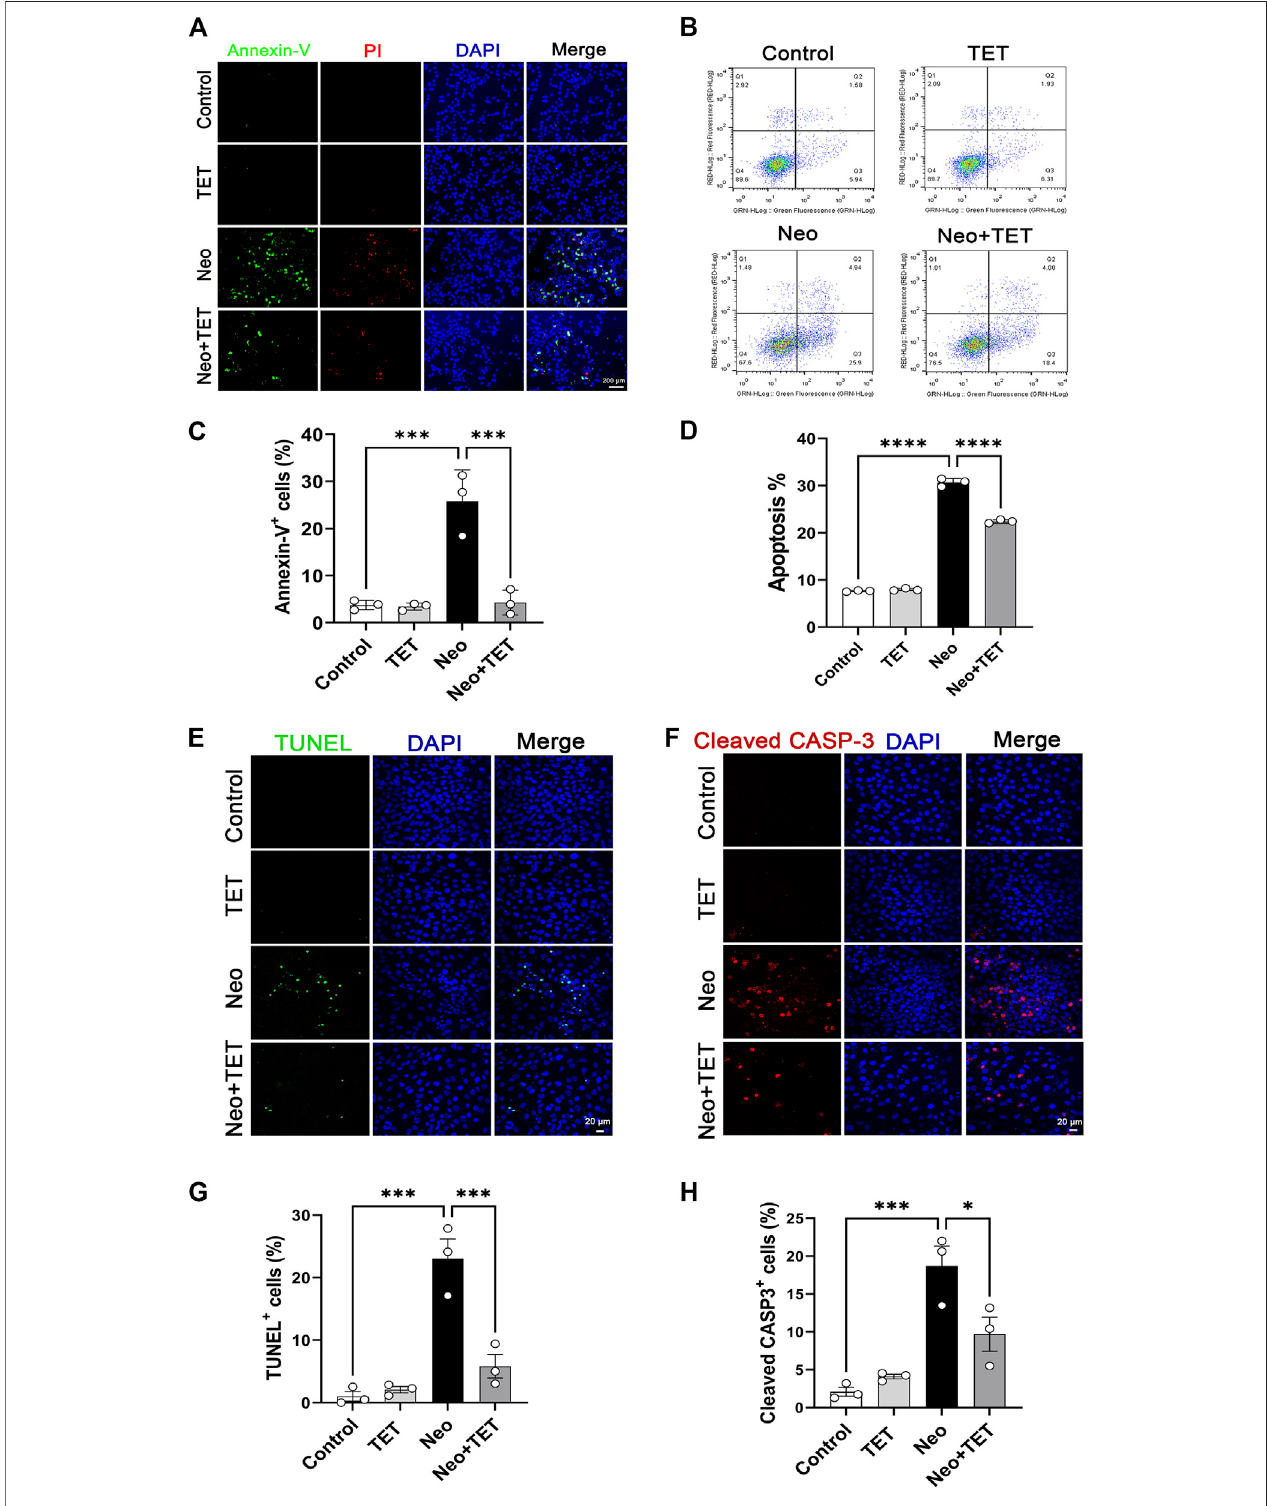
FIGURE3| EffectsofTETonneomycin-stimulatedapoptosisinHEI-OC1cells (A) Annexin-V/PIstaininginHEI-OC1cellsafterTETtreatmentfollowedbyneomycin stimulation.Scalebars:200 μ m (B) ApoptosisanalysisofHEI-OC1cellsby fl owcytometry (C) Quanti fi cationofthenumbersofAnnexin-V-positiveHEI-OC1cellsin (A) (n = 3) (D) Quanti fi cation of the proportions of apoptotic cells (n = 3) (E,F) TUNEL and cleaved caspase-3 staining of HEI-OC1 cells after TET administration followed by neomycin exposure. Scale bars: 20 μ m (G,H) Quanti fi cation of the numbers of TUNEL/cleaved caspase-3-positive HEI-OC1 cells in (E,F) (n = 3). * p < 0.05, *** p < 0.001, **** p <